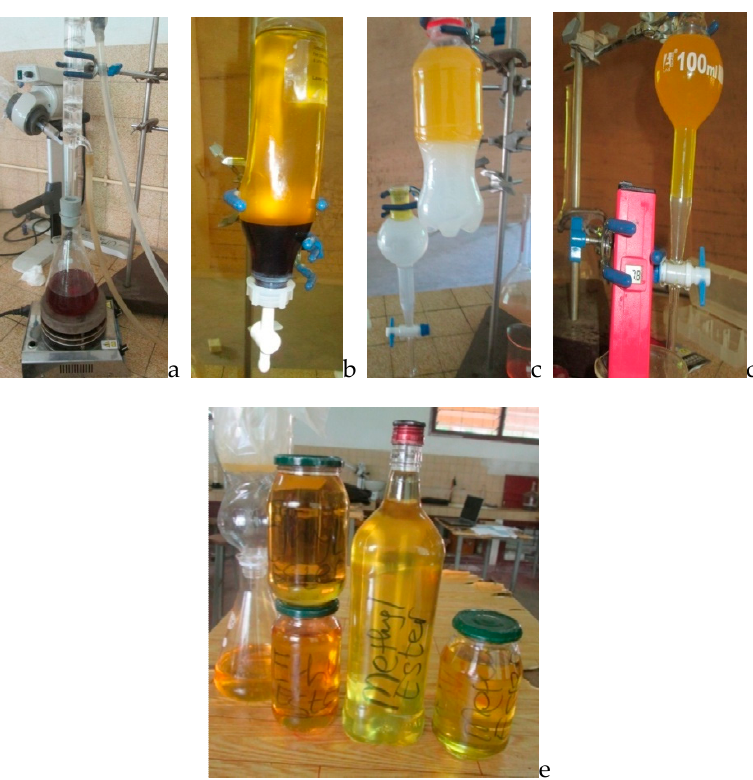
Figure 1. Biodiesel production process: ( a ) production, ( b ) separation, ( c ) and ( d ) washing, and ( e ) final products.